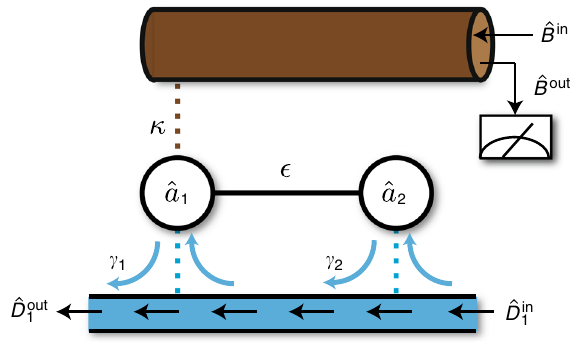
Fig. 5 Implementation of a simple nonreciprocal two-mode sensor. Both modes are coupled to a single effective chiral waveguide; no coupling to gain baths is required. This system is capable of arbitrarily exceeding the fundamental bound on the measurement rate of any reciprocal two-mode sensor. The required chiral waveguide could be realized using circulators, dynamic modulation 28 , or by using driven parametric interactions and external dissipation 29 . Symbols follow that in Fig. 1 and γ i (cid:4) Z i 1 j j